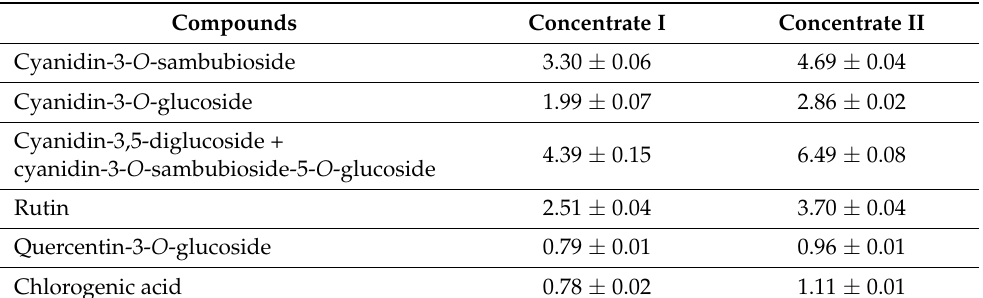
Table 2. Contents of individual phenolic compounds in the initial elderberry concentrates quantified by HPLC in g kg − 1